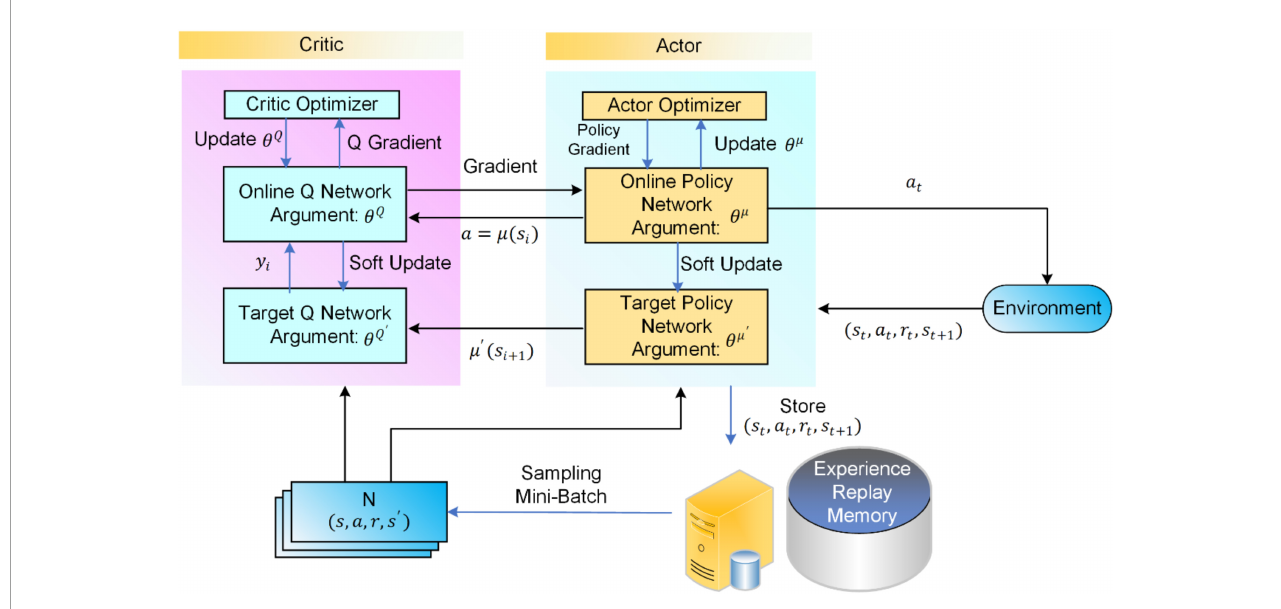
FIGURE1 Flowchart of the deep deterministic policy gradient (DDPG)